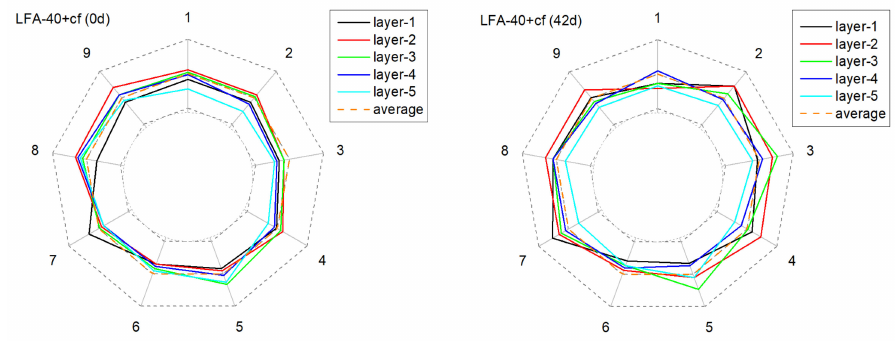
Figure 14. The deviation of the current from the mean value of current over time at different positions in the anode sample during the AAT (LFA-40+cf).